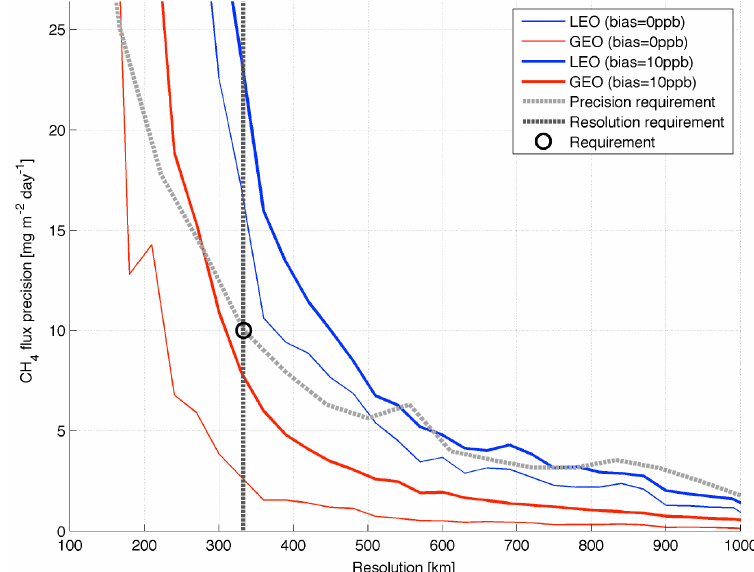
Figure 8. Median retrieved LEO and GEO CH 4 fluxes for L = 150–990km; the dashed lines indicate precision and resolution requirements. See Table 1 for details on GEO and LEO CH 4 observing systems. The bias value of 10ppb indicates modeled systematic CH 4 measurement biases with 100km spatial correlations (see Sect.